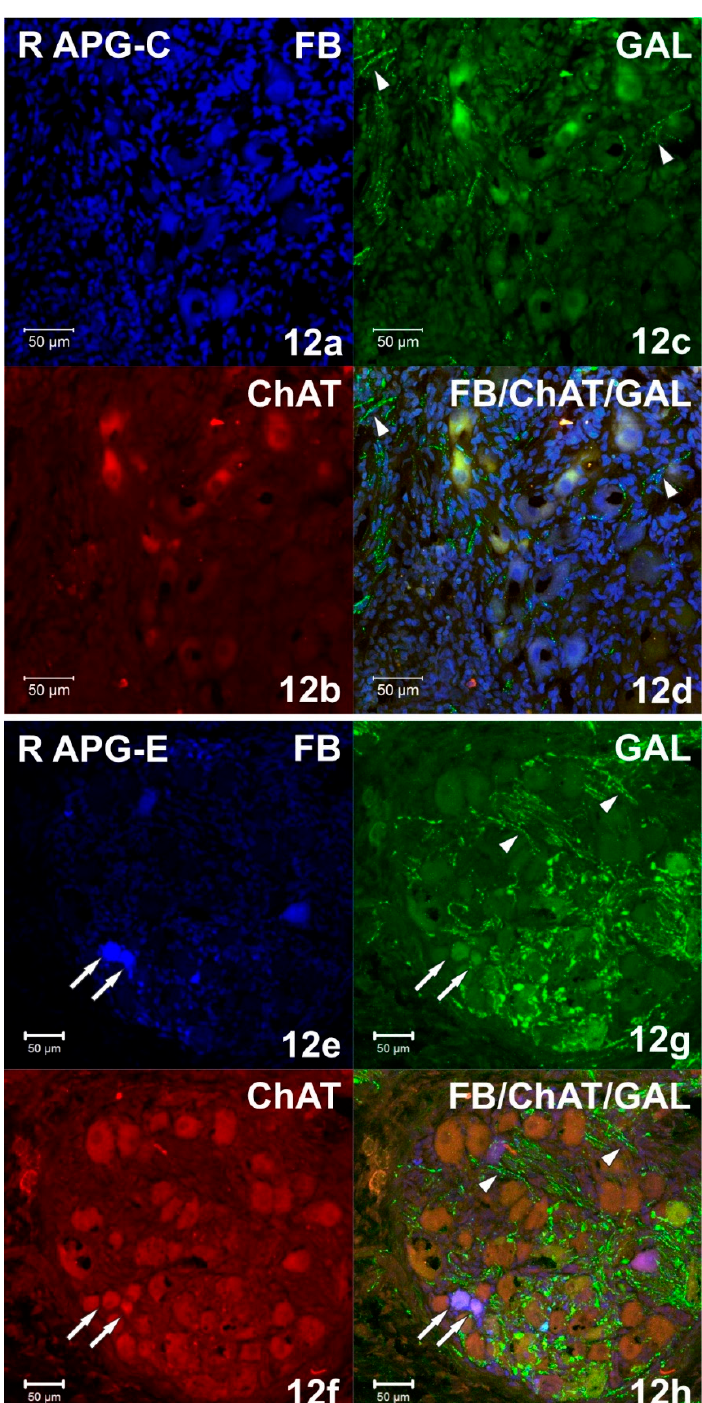
negative ( b ). The arrowhead indicates the low number of VIP-IR fibers ( c , d ). The images were taken from blue, green and red fluorescent channels. Blue, green and red channels were digitally super- imposed. Scale bar = 50 µm. ( e – h ) Confocal laser scanning microscope images showing a section of the right (R) APG from the experimental group. Arrows indicate FB+ neurons ( e ) simultaneously immunoreactive ( h ) against VAChT ( f ) and VIP ( g ). A large number of VIP-IR fibers ( g , h ) were marked with the arrowhead. The images were taken from blue, green and red fluorescent channels. Blue, green and red channels were digitally superimposed. Scale bar = 50 µm.